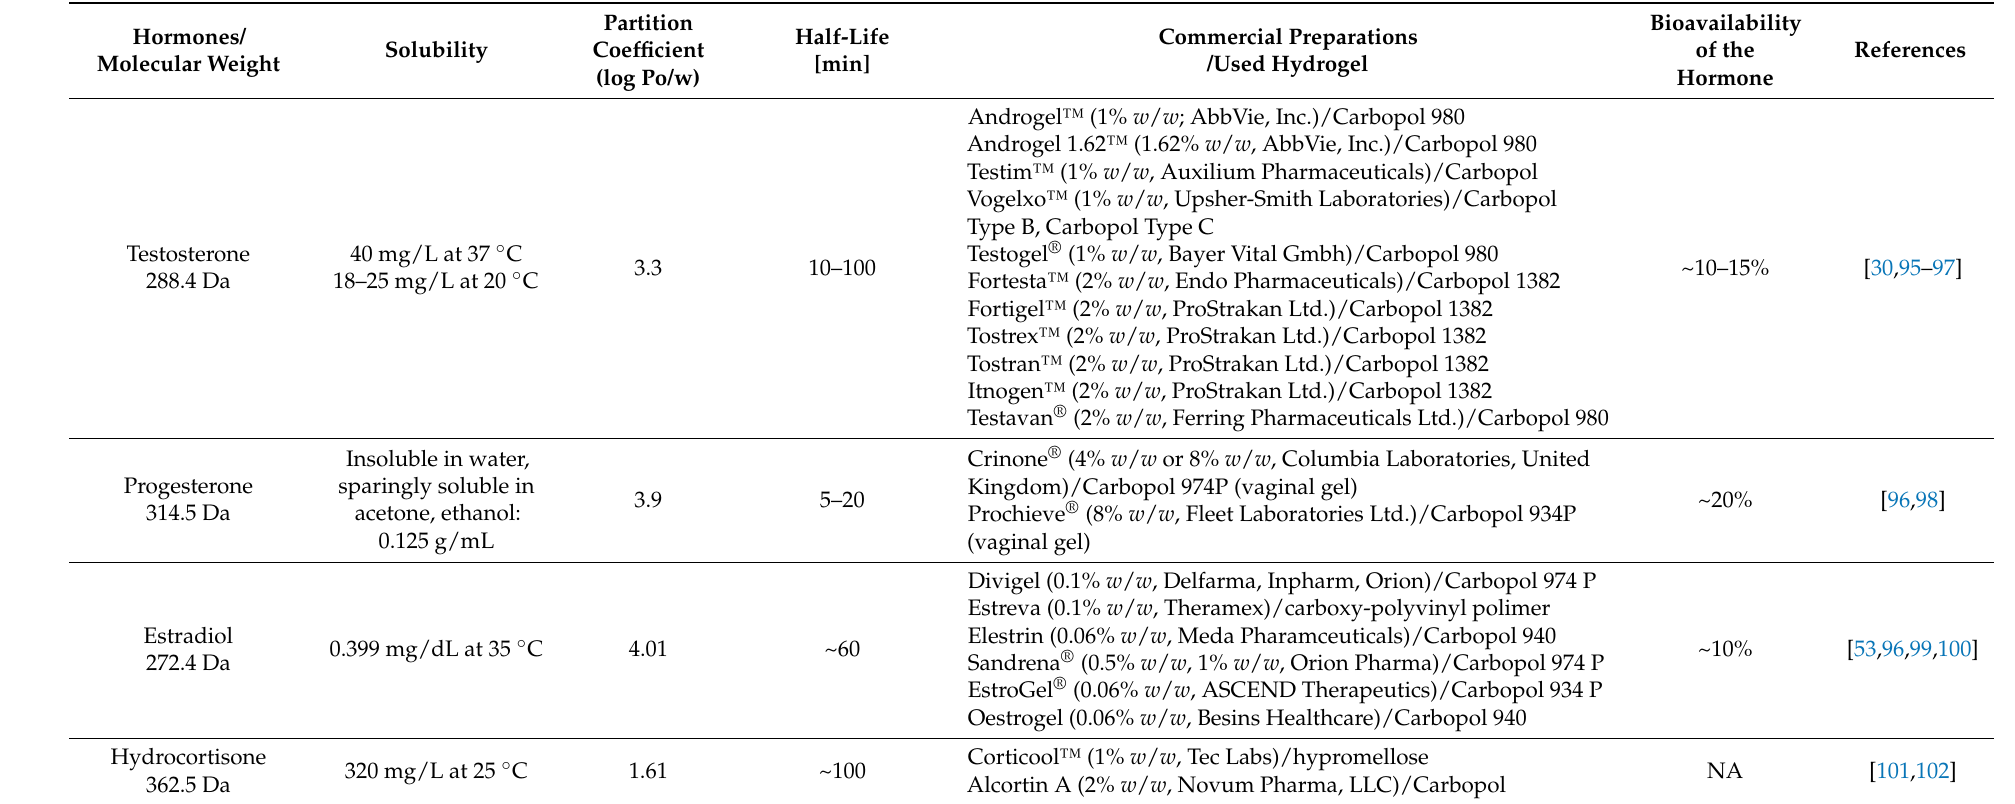
Table 2. Physicochemical parameters of hormones and examples of commercial hydrogels containing